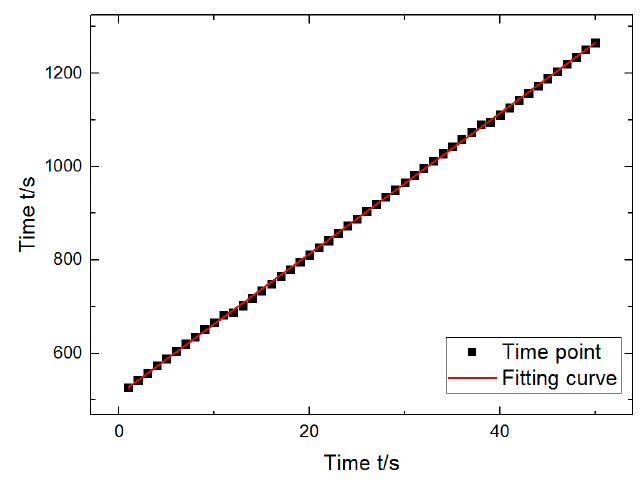
Figure 6. Time zero fitting curve.